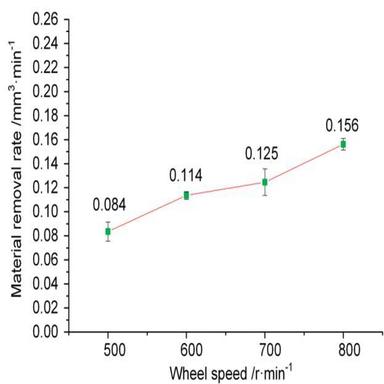
Material removal rate versus wheel speed.